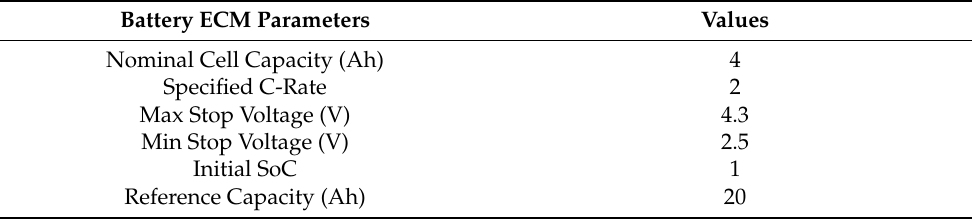
Table 2. Electric circuit model Settings.